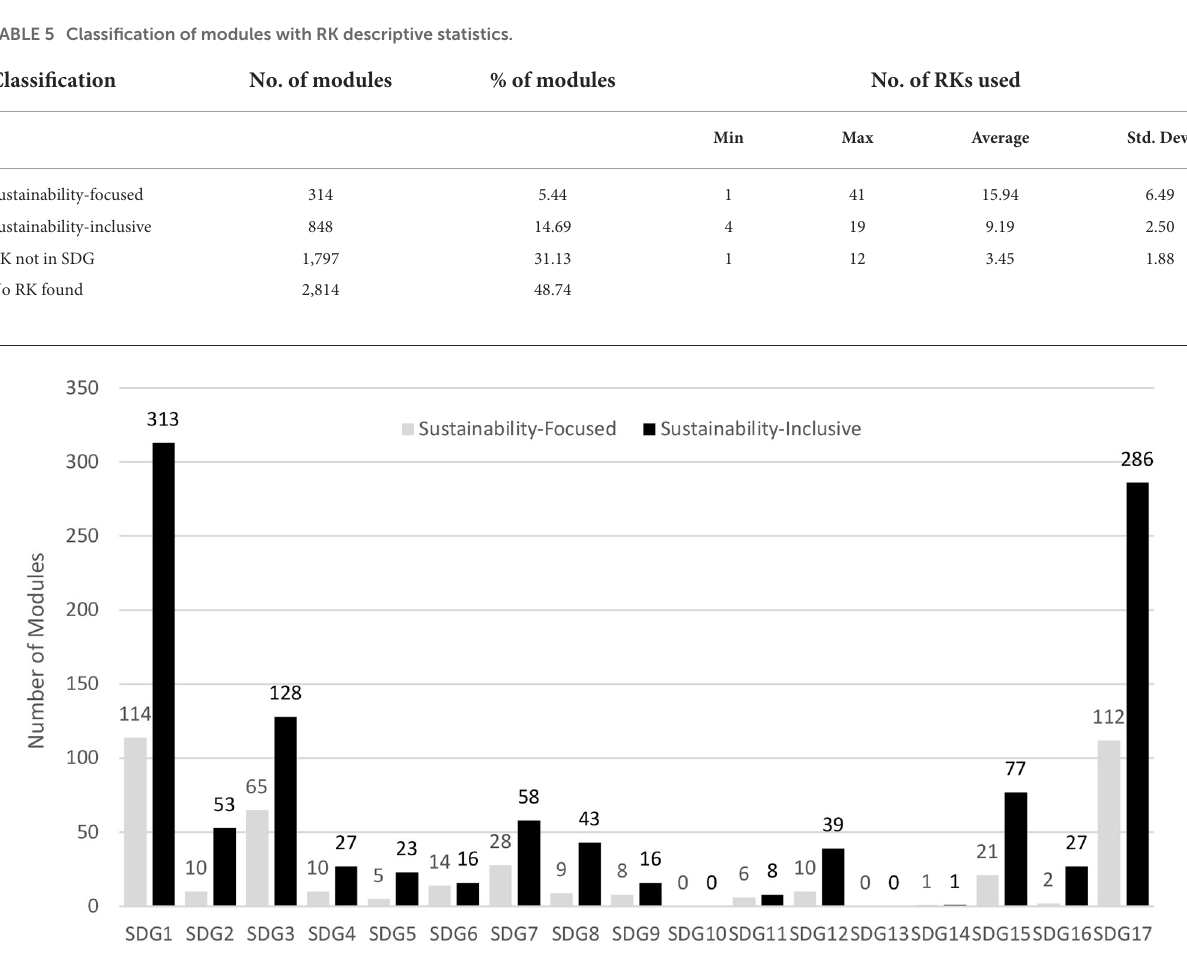
with more than twice the number of RKs found in modules that do not use “sustainab.” However, some modules do not use “sustainab,” yet have as much or more enriched vocabulary than modules using the “sustainab,” thereby more being likely to be “sustainability-focused.” To determine the probability for “sustainability-focused” and “sustainability-inclusive” modules using the average number of distinguishable RKs, the following criteria were